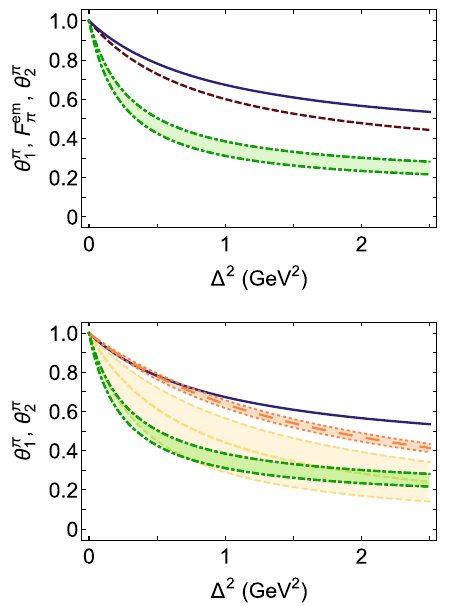
Fig. 3 Upper panel. Pion form factors computed from the twist-two vector GPD: solid blue curve – mass distribution, θ 2 ; dashed dark- red curve – elastic electromagnetic, F em π ; and green dot-dashed curves with associated band – pressure, θ 1 . Lower panel. Comparison of CI results for θ 1 , 2 with those obtained using lQCD, viz. θ lQCD short-dashedcurvewithinlike-colouredband;and θ lQCD dashed curve and band. The bands enclose the envelope of curves that fit the lQCD results